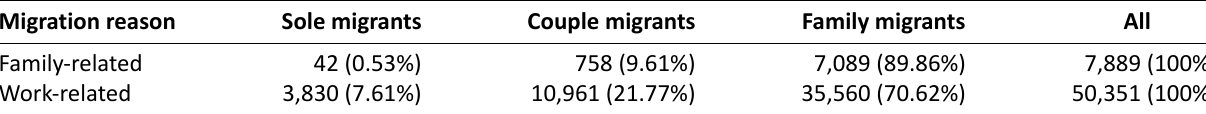
Table 2. Household arrangement by migration